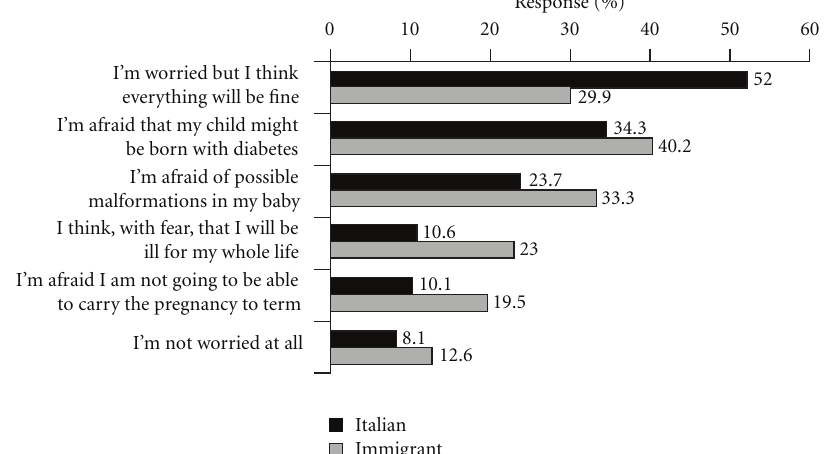
Figure 1: Patients’ current concerns in relation to pregnancy. (The sum exceeds 100% because multiple answers were possible). The di ff erences between Italian and Immigrant pregnant women are significant ( P < 0 . 05).